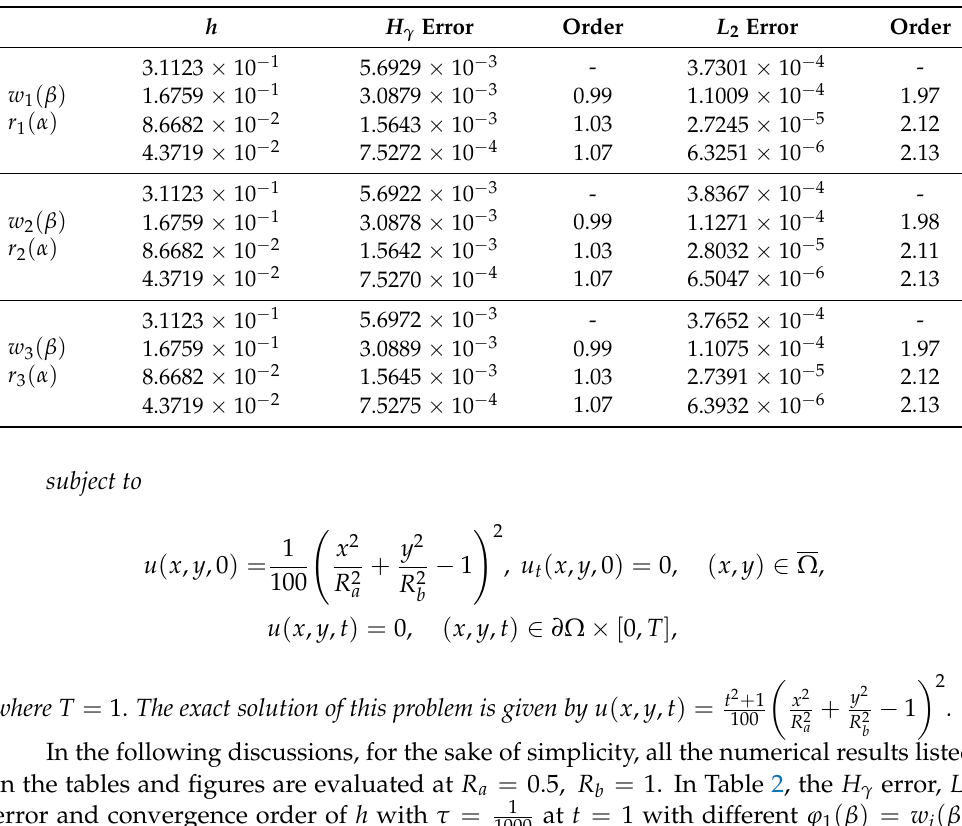
at t = 1 for the case ξ = 1000